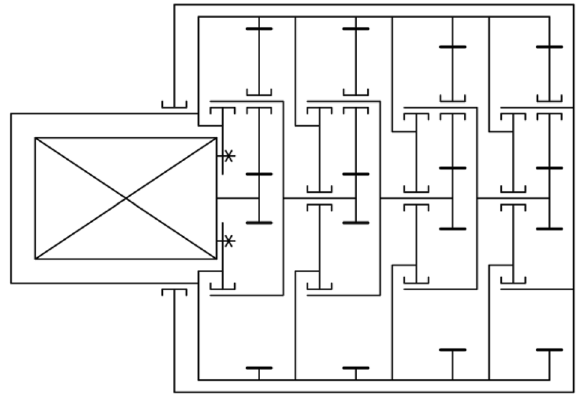
Figure 1. Diagram of the designed planetary gearing.